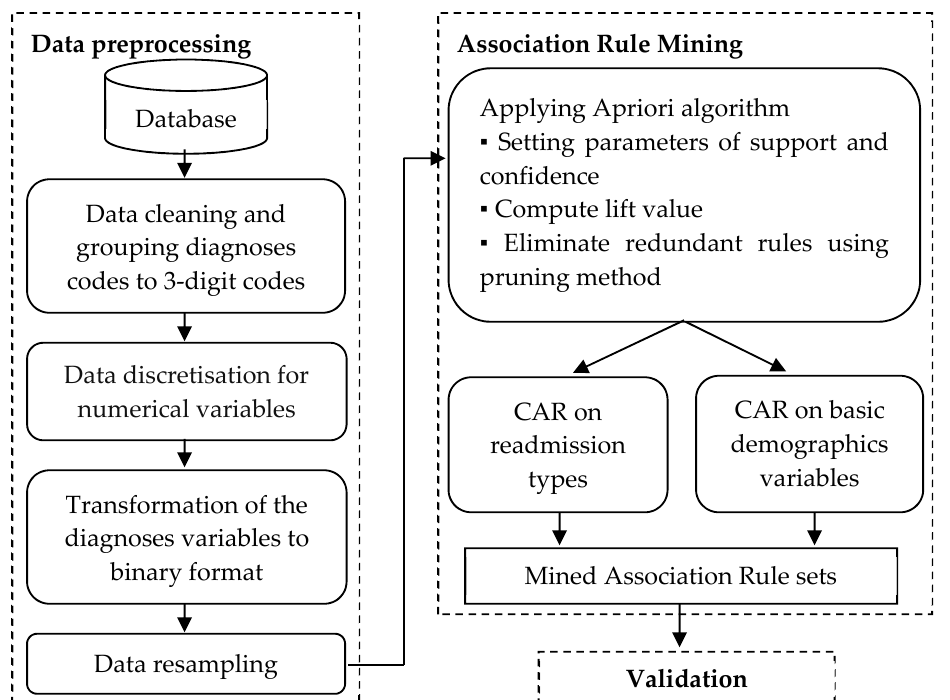
Figure 1. The complete research framework of ARM for hospital readmission.